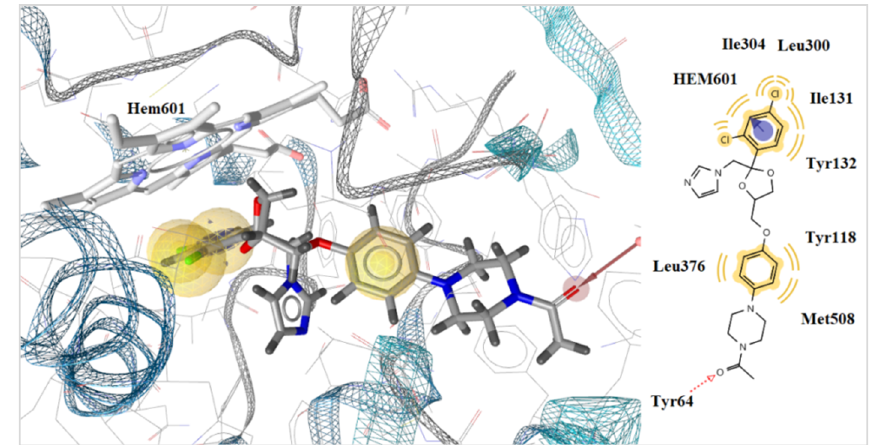
Figure 2. Docked conformation of ketoconazole in lanosterol 14α-demethylase of C . albicans (CYP51 ca ).